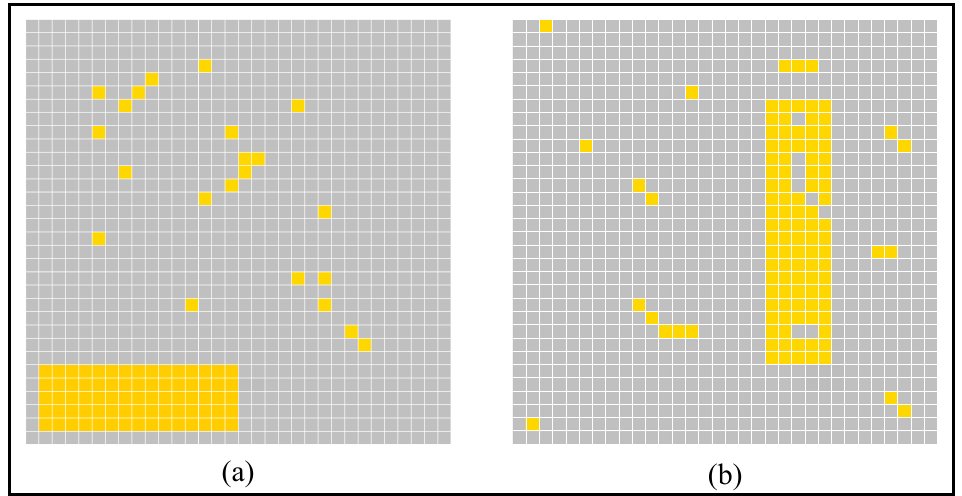
Figure 17. Two types of noise. ( a ) Random noise only in the background. ( b ) Random noise in the whole image.